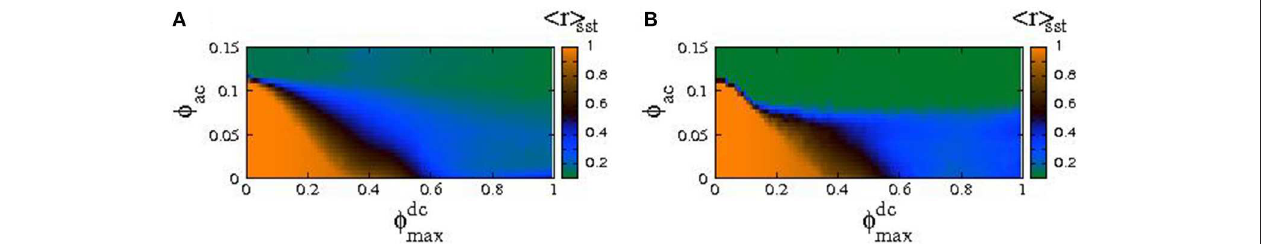
r mapped as a function of the ac flux amplitude h i sst